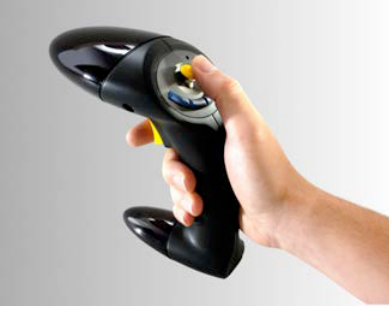
Figure 16. The Flystick 2 device